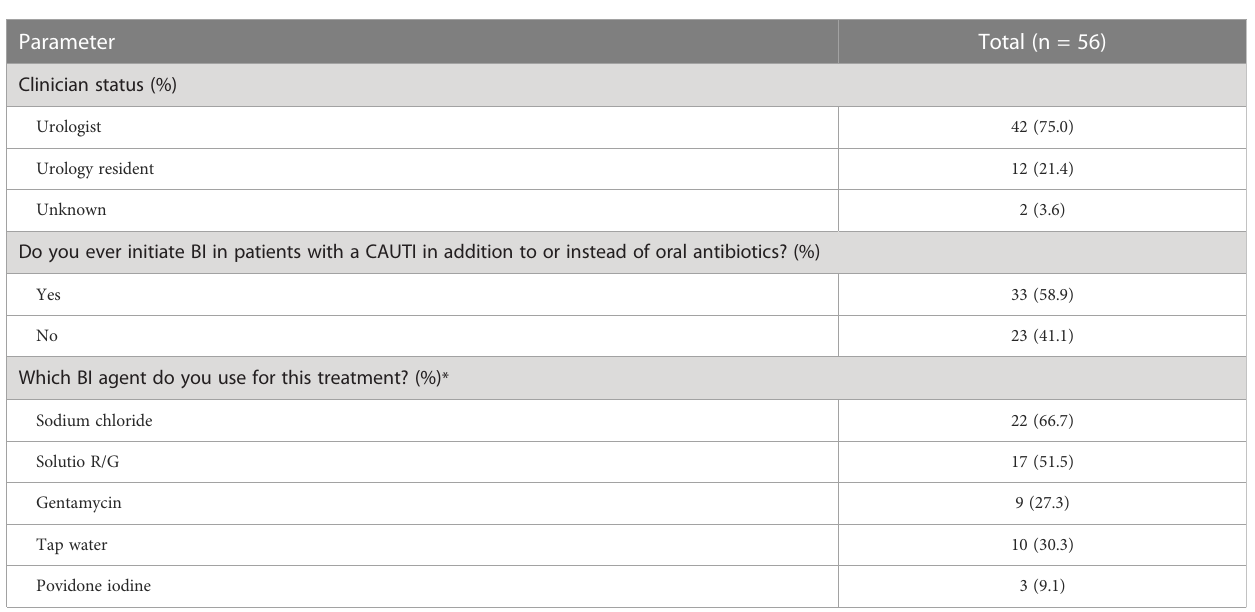
TABLE 4 Clinician